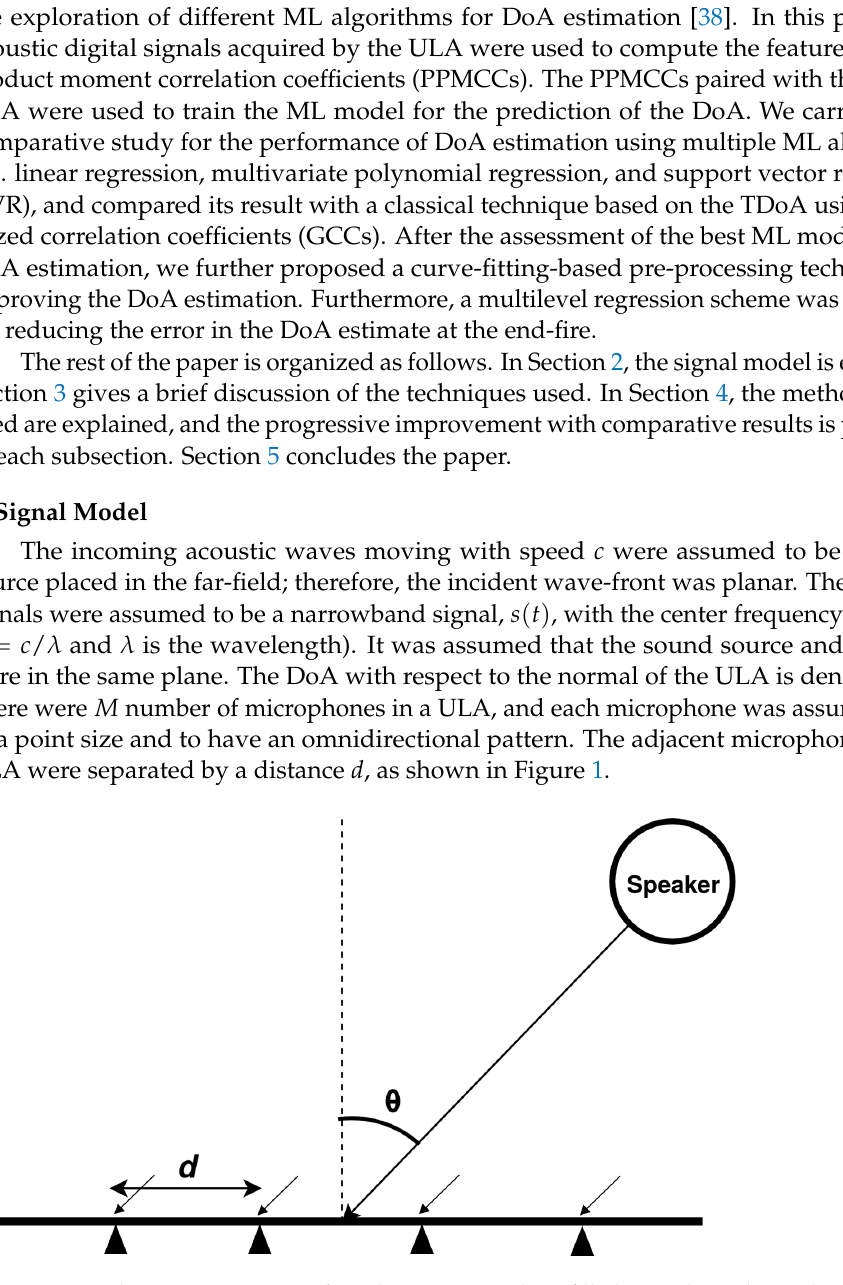
Figure 1. Signal impinging on a uniform linear array, where filled triangles indicate the position of omni-directional